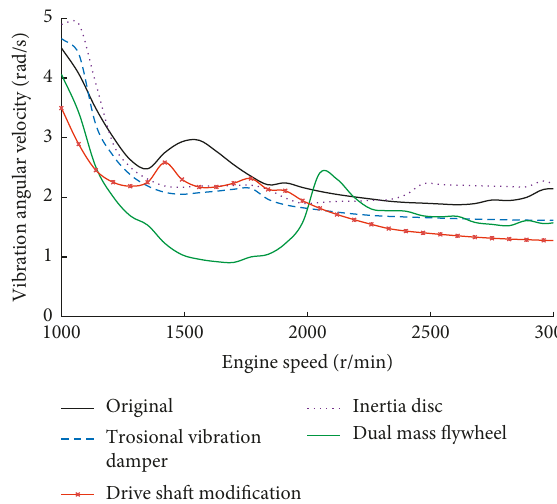
Figure 28: Driveline torsional vibration simulation results of drivetrain modifications.